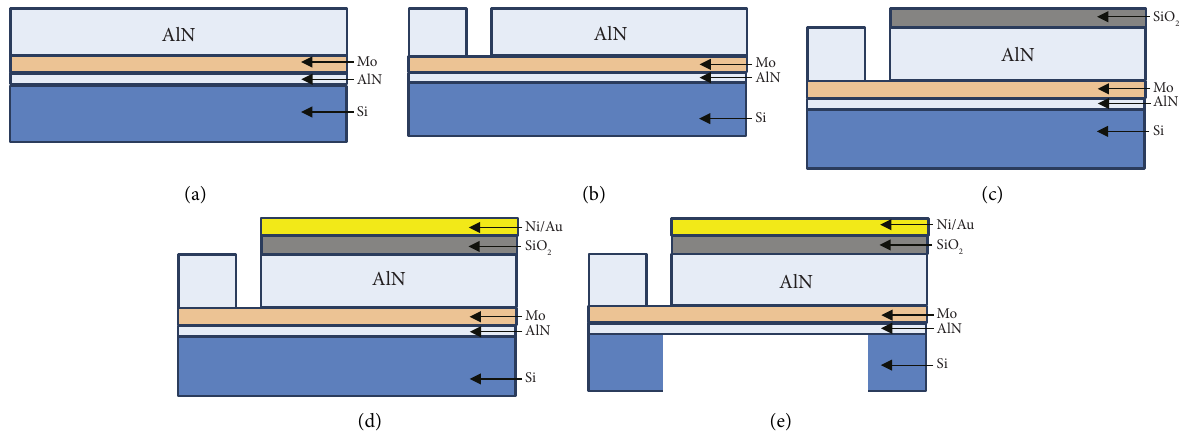
Figure 3: Te illustration of fabrication protocol for FBAR chip. Te upper electrode is Ni/Au, the bottom electrode is Mo. Te piezoelectric material of the sensor is AlN. (b) Is for the photolithography and etching of the front side, (c) is for the SiO 2 deposition, (d) is for upper electrode deposition, (d) is for back etch. Table 2: Te photolithography parameters of the fabrication. Which step Photoresist Exposure